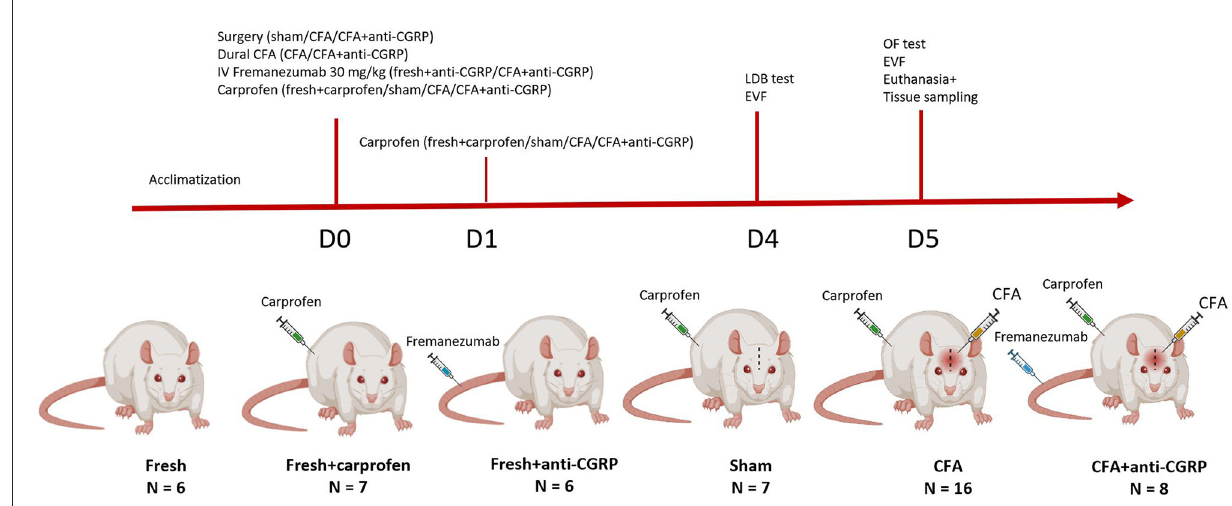
anxiety-like behavior, exploration and head pain/sensitivity were distance traveled (meters), time spent in the central zone (seconds), number of rearing episodes and time spent head grooming (seconds), respectively. Rats were put in the room at 9:30 a.m. in their cages for acclimatization. Testing was performed between 10 and 12 a.m. Rats were taken out of their cages individually and put in the center of the enclosed area. Once placed, the rat was recorded with a camera and tracked using the ANY-MAZE software while another investigator manually counted rearing episodes as well as head grooming time. Rats were monitored for 10min. The testing surface was then cleaned with 20% ethanol to remove the scent of previous rats to avoid discrepancies and distractions between tests.